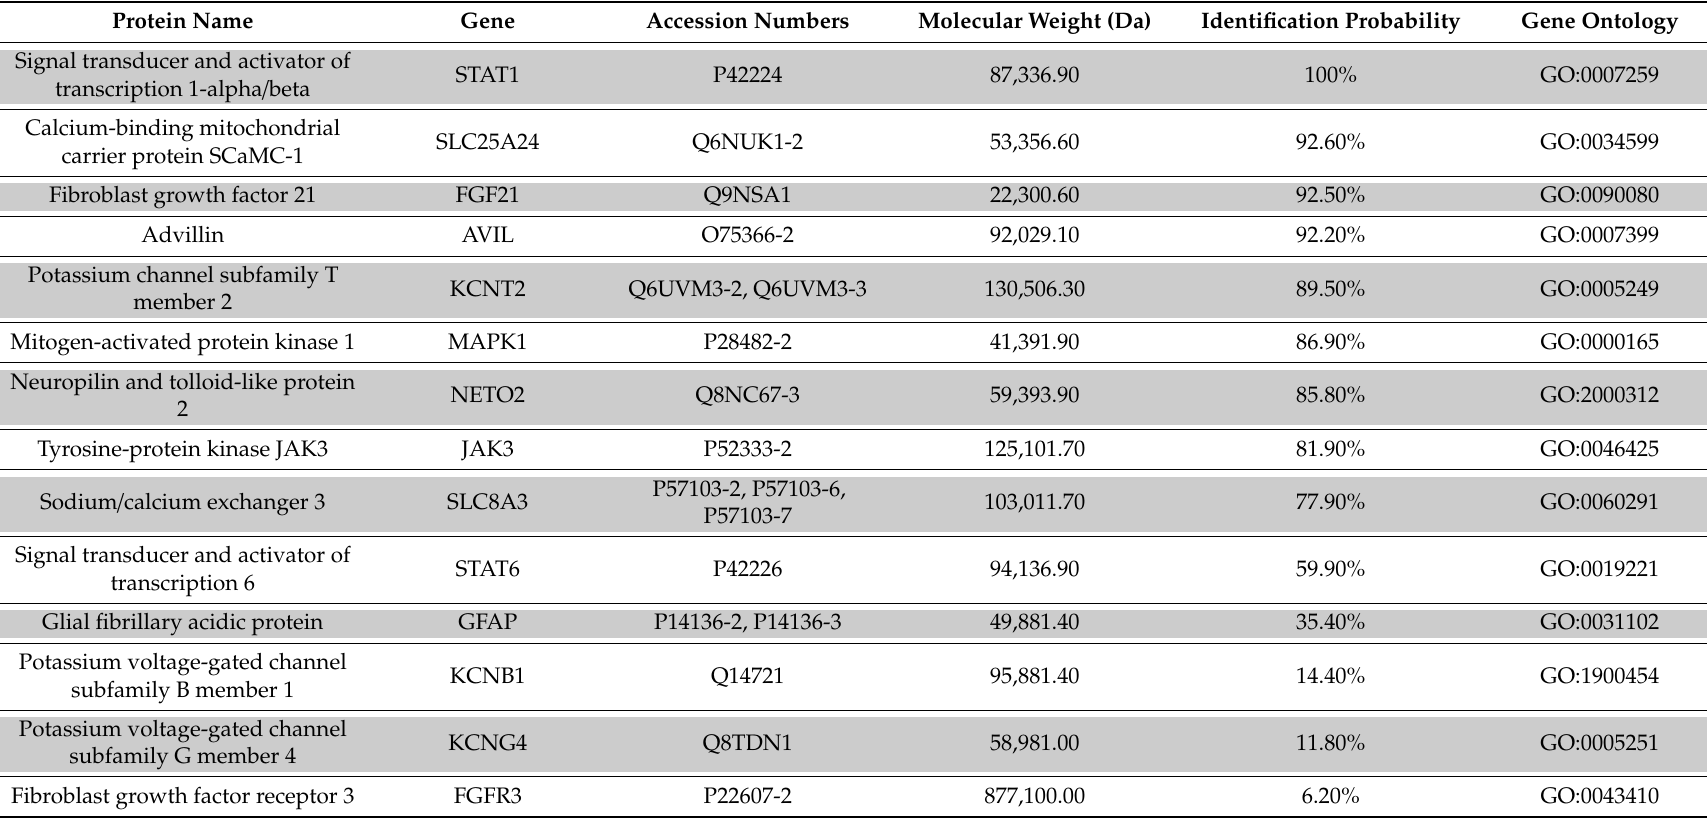
Table 3. Proteins involved in the proposed VPA induction pathway of neural di ff erentiation of